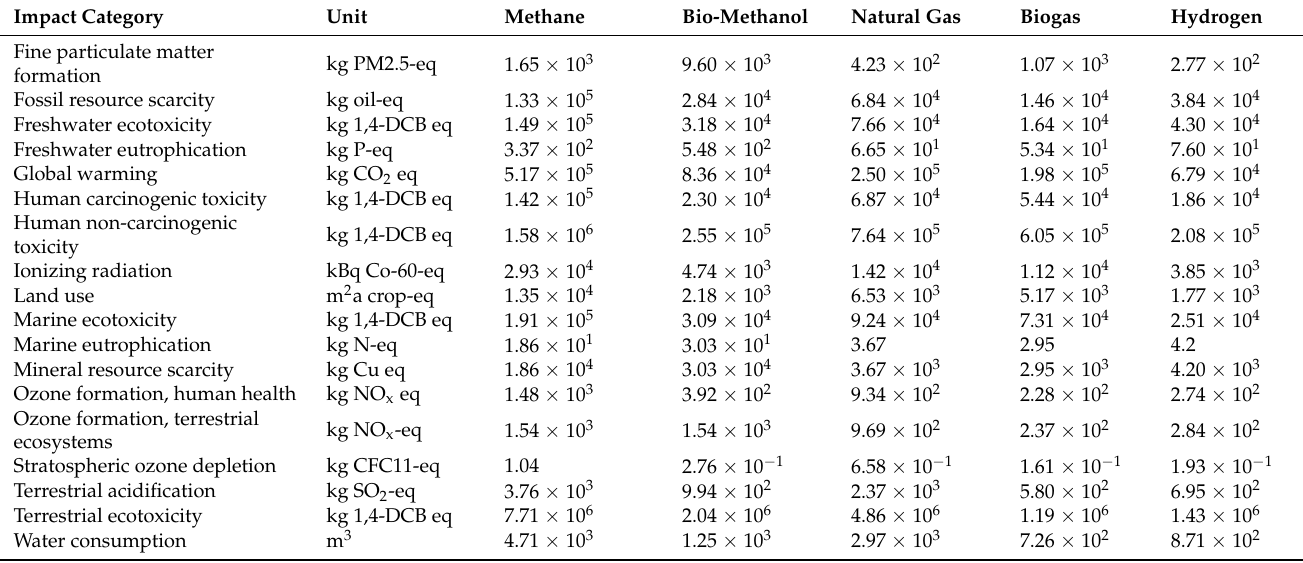
Table 9. The comparison between different types of input fuel for the SOFC stacks and their impacts on the environment based on ReCiPe 2016 v1.03 Midpoint (H) for the suggested design of the 246.02 kWh charging station.